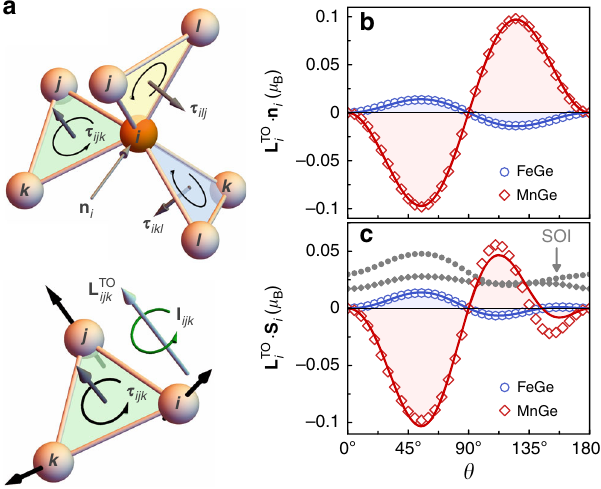
Fig. 4 Topological orbital magnetism in B20 germanides. a The central magnetic atom and its magnetic neighbours form three symmetry-related triangles with corresponding normal vectors τ ijk . Owing to the non-coplanar spin con fi guration of each such triangle, the fi nite persistent electron current I ijk , indicated by the green arrow, contributes to the orbital moment. b , c Projections of the resulting topological orbital moment L TO i of the i th atom type onto the local symmetry axis n i , and the local spin direction S i . Open symbols refer to fi rst-principles results and solid lines are the model fi t. In addition, we mark by small full symbols in c the ab initio SOI contribution to the orbital